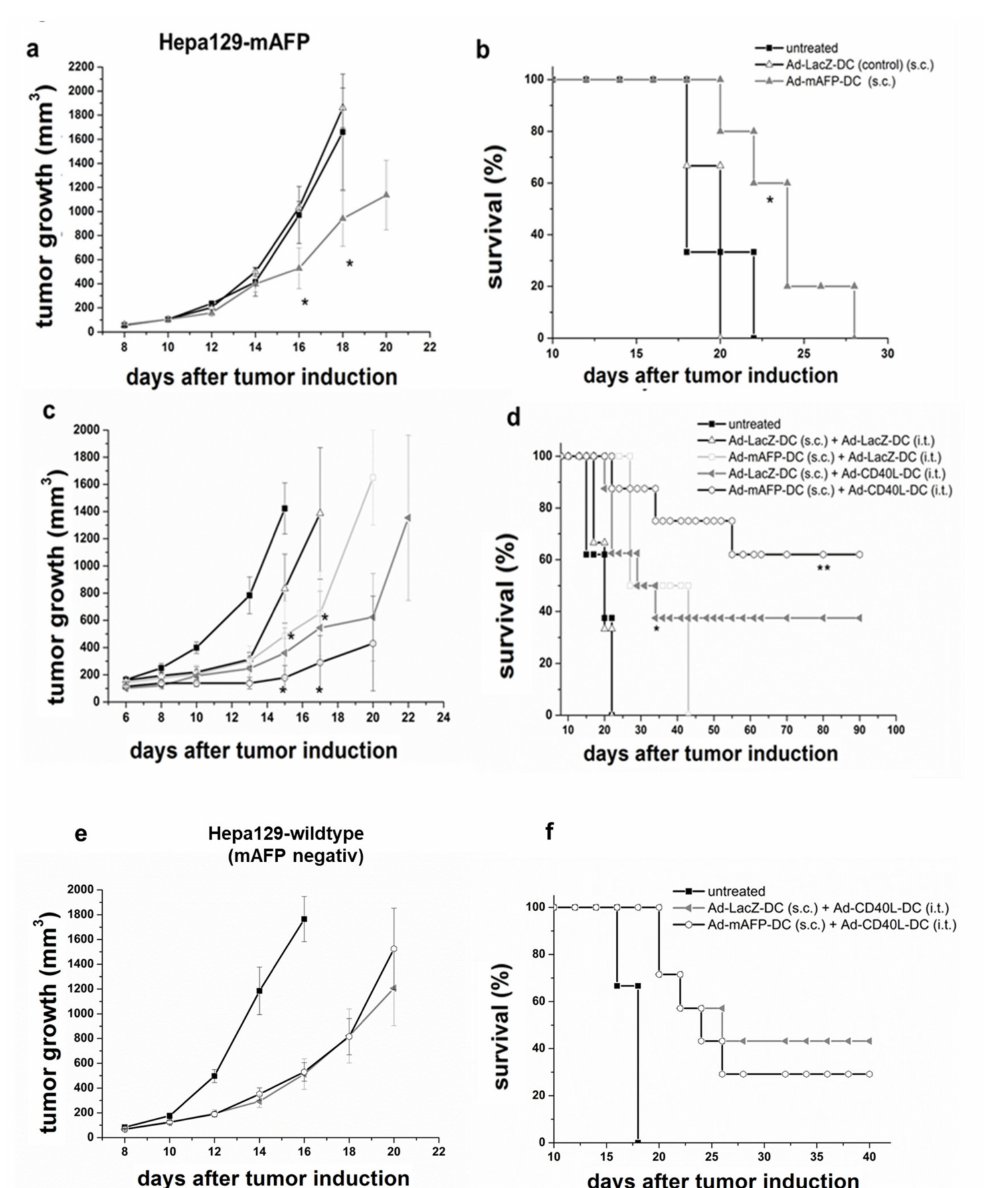
Figure 2. Antitumoral effects of vaccination with Ad-mAFP-DC alone or in combination with Ad-CD40L-DC in pre- established HCC. ( a , b ) Tumors were induced s.c. with 10 6 Hepa129-mAFP-cells. When tumors reached 60.6 ± 16mm 3 (approximately 7–10 days after tumor induction), 10 6 Ad-mAFP-DC or 10 6 Ad-LacZ-DC were injected into the left flank of mice. Graphic shows tumor growth ( a ) and Kaplan-Maier survival curves ( b ) of a representative experiment ( n = 6 each group) from two different experiments. Data are given as mean tumor volumes (mm 3 ) with SEM. (* p < 0.05 compared to s.c. Ad-LacZ-DC). ( c , d ) Animals were treated s.c. with 10 6 Ad-mAFP-DC, as described above, followed by an i.t.-injection of 10 6 Ad-CD40L-DC five days later. Graphics show tumor-growth ( c ) and Kaplan-Maier survival curves ( d ) of one representative experiment ( n = 8 each group) from three independent experiments. Data are given as mean tumor volumes (mm 3 ) with SEM. (* p < 0.05, ** p < 0.01 compared to s.c.-Ad-LacZ-DC/i.t.-Ad-LacZ-DC). ( e , f ) Combined heterotopic DC-treatment in s.c. pre-established AFP-negative HCC ( e ) and Kaplan-Maier survival curves ( f ). Animals were treated as described above. Graphic shows one representative experiment ( n = 6 each group) from two independent experiments. Data are given as mean tumor volumes (mm 3 ) with SEM. The lines marked with circles, triangles or squares were chosen to distinguish different treatments and represent time-points. Significance was determined using the log-rank